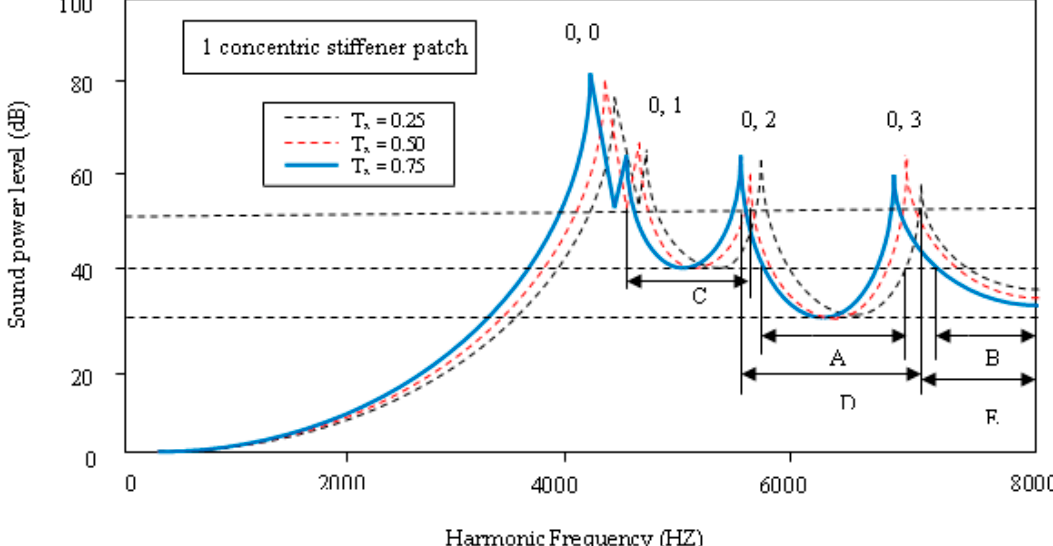
Figure 13. Numerical comparison of sound power level for annular plate attached with 1 concentric stiffener patch and having parabolic decreasing thickness variations (Case I) for different taper ratios T x .